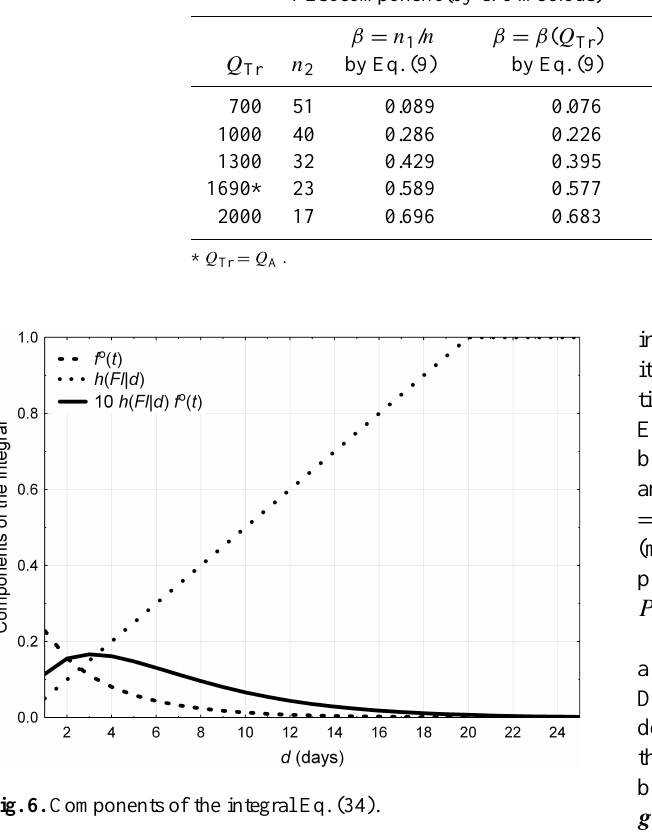
Second component, f ◦ is the